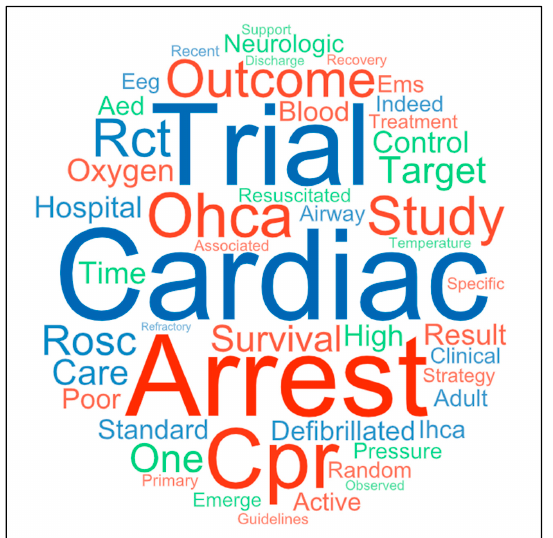
Figure 3. Word cloud of the 50 most common terms present in the 11 randomized clinical trials included in the review.